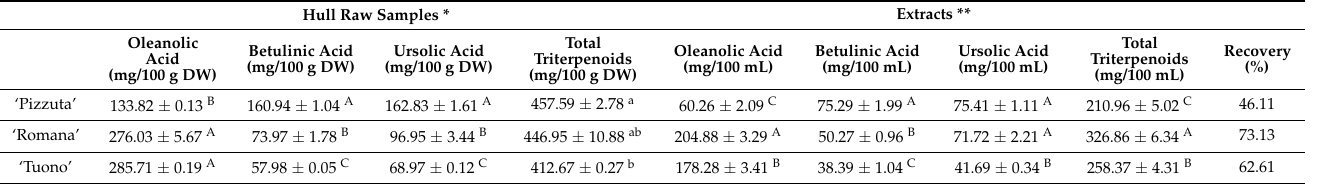
Table 1. HPLC-PDA analysis of triterpenoids in ‘Pizzuta’, ‘Romana’ and ‘Tuono’ hull raw samples (H) and extracts